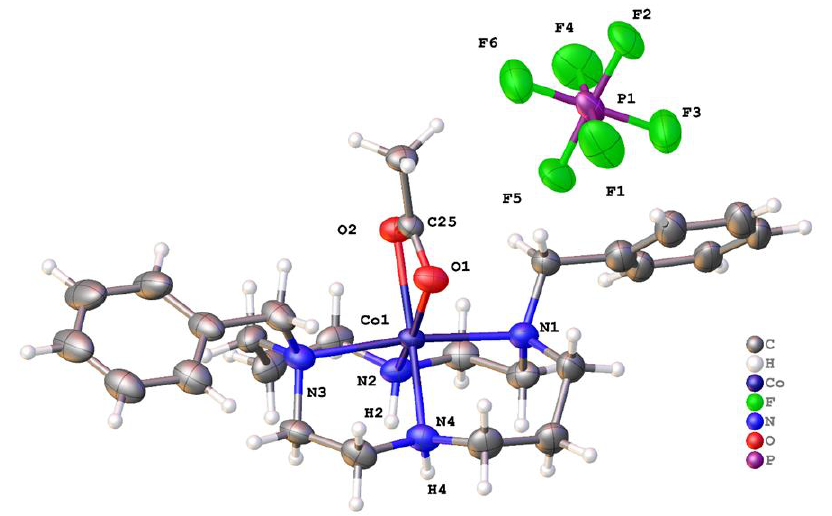
Figure 9. Molecular structure of [Co( 2 )(OOCCH 3 )]PF 6 . Atoms are drawn as 50% probability ellip- soids. For clarity, minor disorder is not represented.